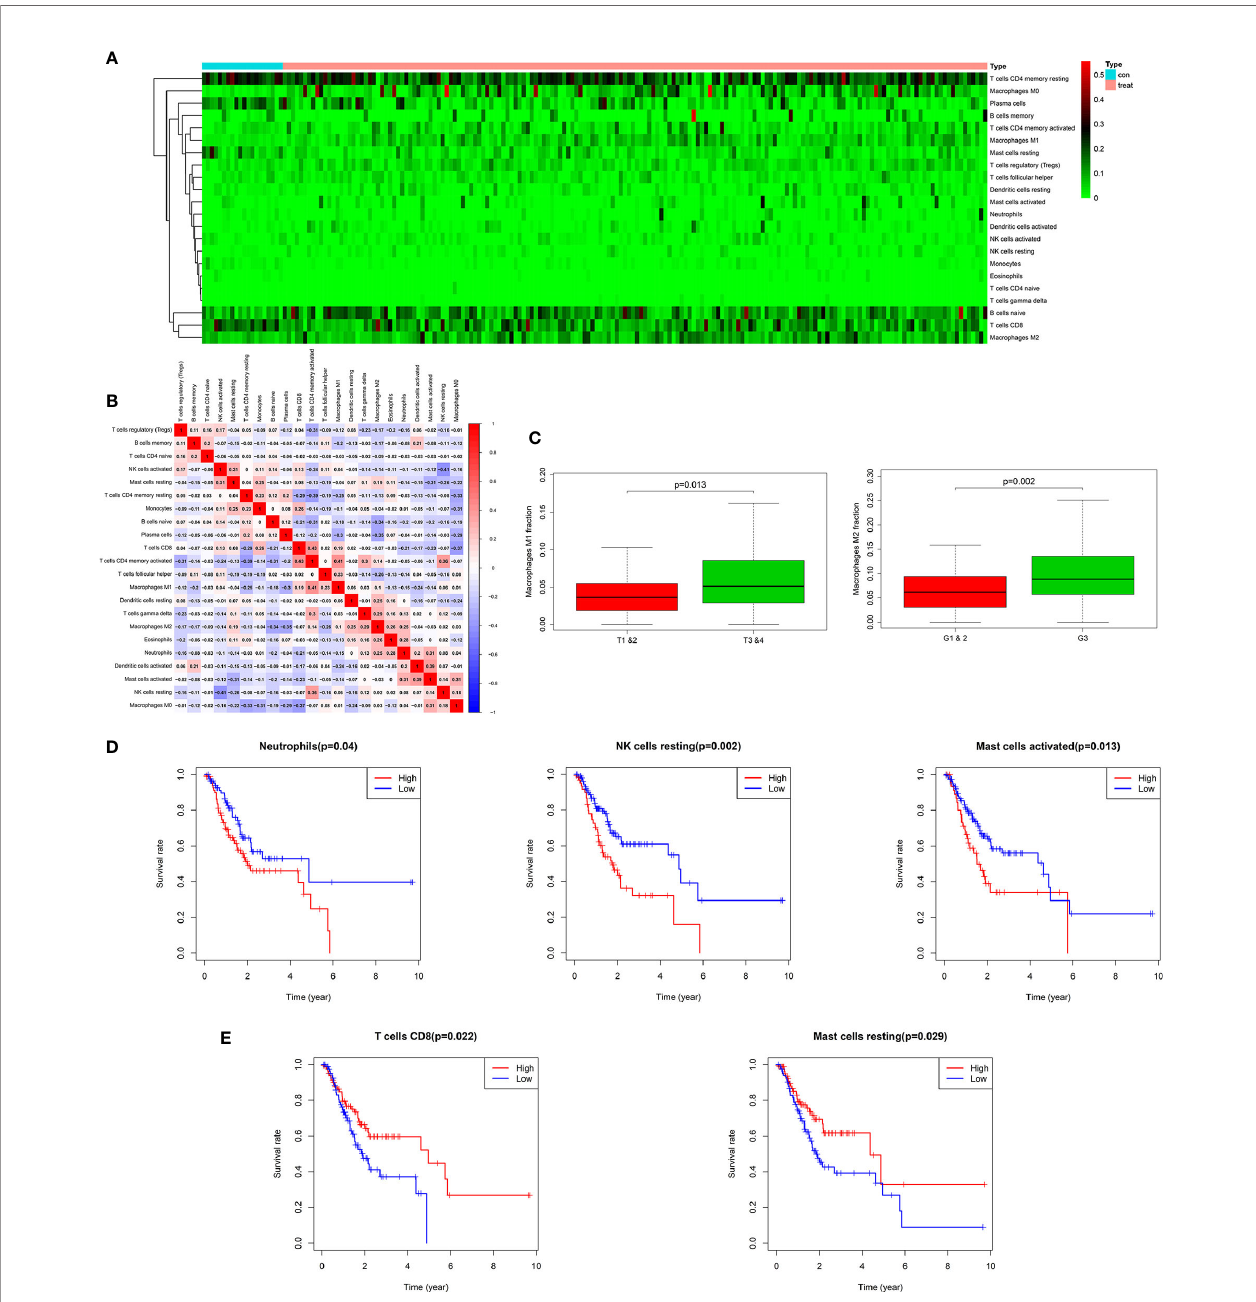
FIGURE 1 | Twenty-two subpopulations of immune in fi ltration cells in AEG tissues. Heat map of the 22 immune cells proportions (A) . Correlation of CD4 + memory activated T cells, CD8 + T cells, M1 macrophages with other immune cells in TCGA (B) . M1 and M2 macrophages were obviously related to stage and histopathologic grading in patients with AEG (p < 0.05). Fraction of M2 macrophages were higher in G3 than in G1&2 tumors. M1 macrophages were lower in T1&2 tumors than in T3&4 tumors (C) . Kaplan-Meier curve for prognostic model showed that high overall survival rates related with fraction of the speci fi c immune cell populations. The high fraction of neutrophils, resting NK cells, and activated mast cells were risk factors to predict survival rate in TCGA cohort (D) . The high fraction of CD8 + T cells and resting mast cells were protective factors to predict survival rate in TCGA cohort (E)